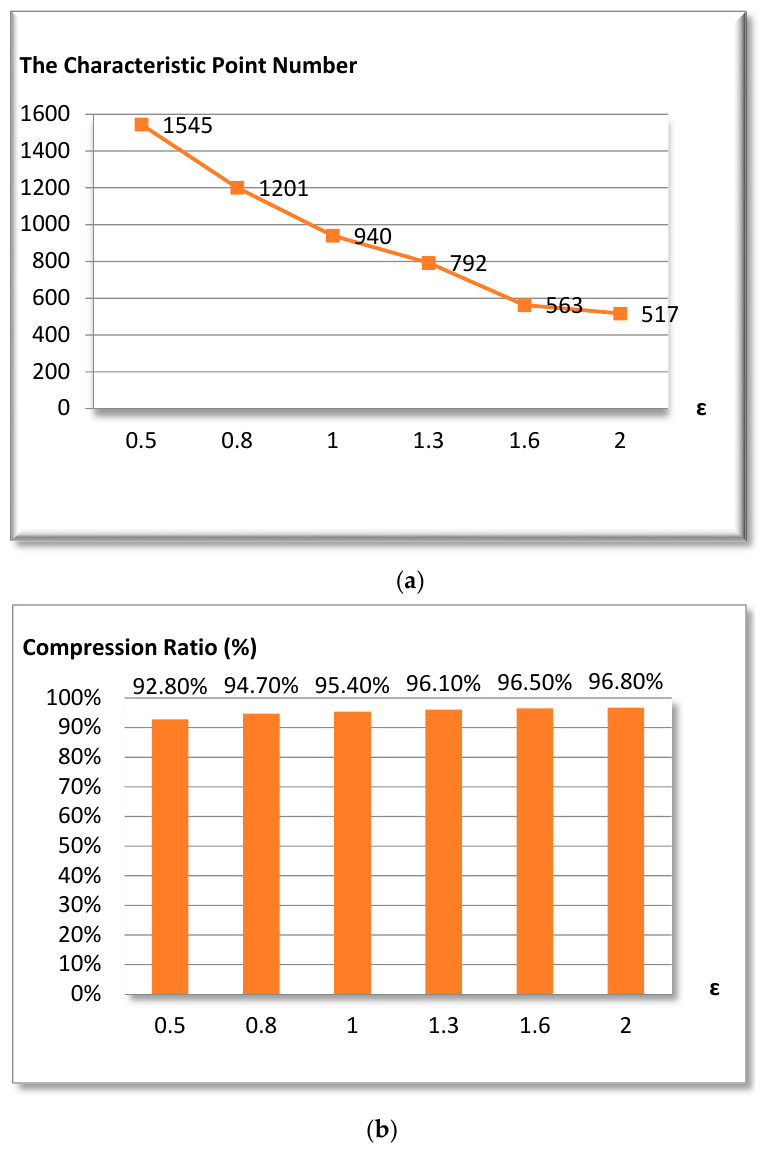
Figure 10. ( a ) The characteristic point number; ( b ) The compression ratio of the vascular tree.